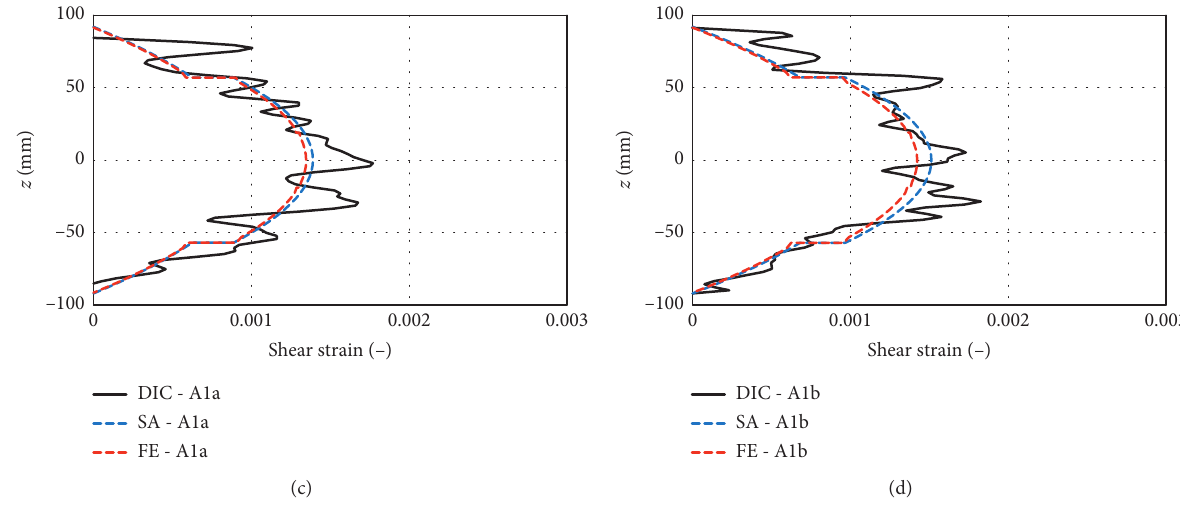
Figure 10: Colour contour plots of A1 and shear strain distribution from bending tests for A1, A1a, and A1b.